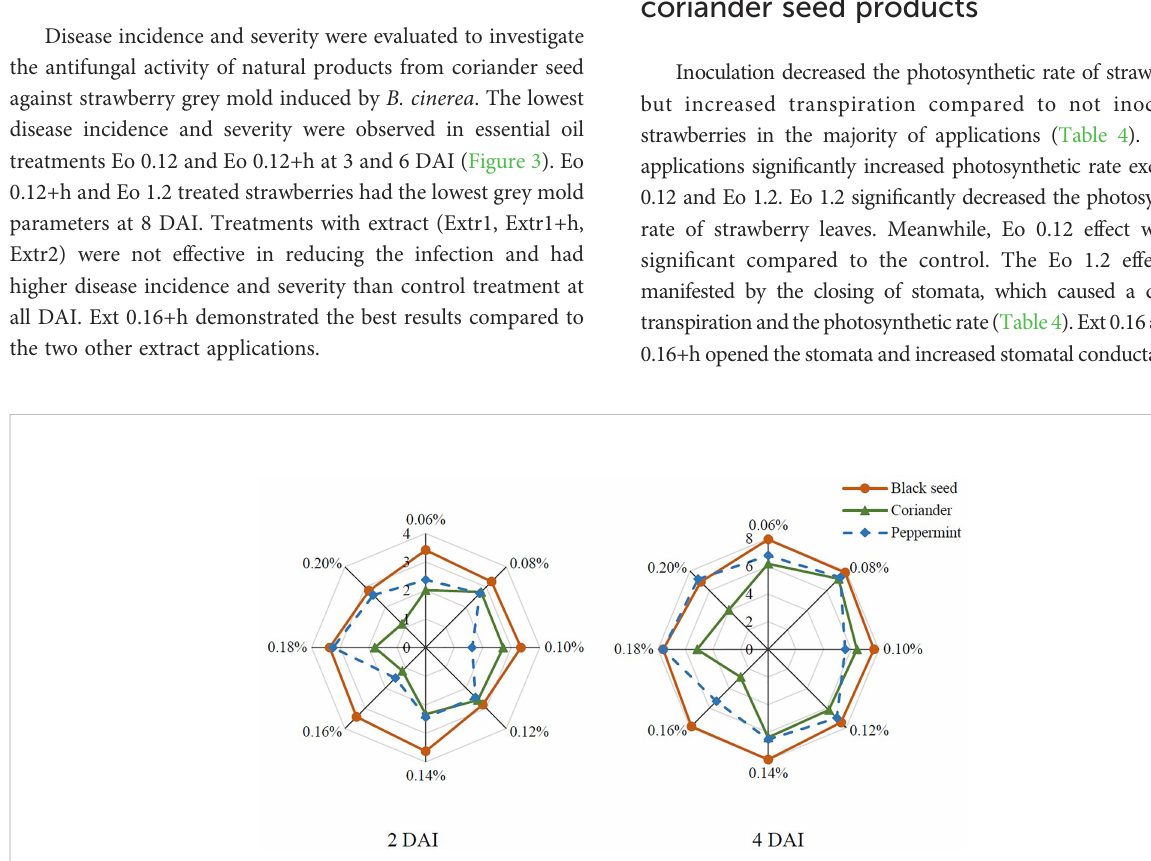
FIGURE 2 The radial colony growth (cm) of B. cinerea on the PDA with black seed ( Nigella sativa ), coriander ( Coriandrum sativum ), and peppermint ( Menta × piperita ) extracts at different concentrations (%); DAI – days after